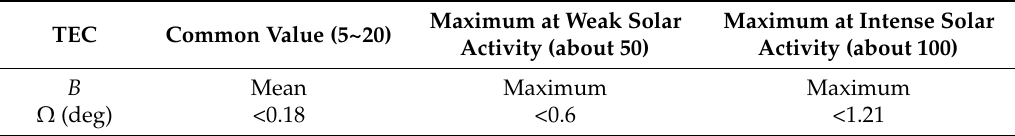
Table 5. Prediction Faraday rotation (FR) of GF-3